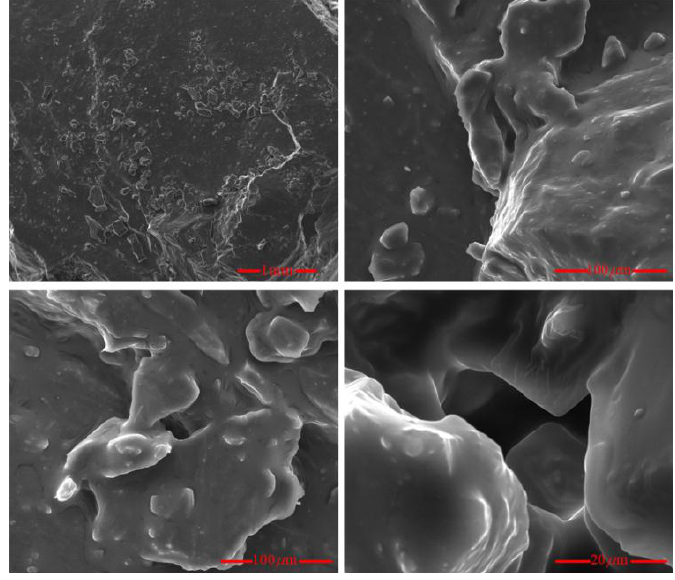
Figure 5. SEM image of the sample.